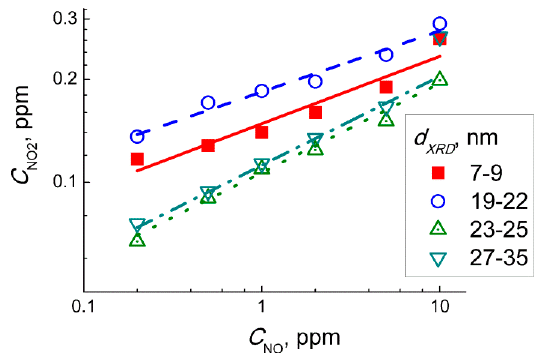
Figure 11. Concentration of NO 2 in the gas mixture NO + air estimated from the sensor signals of WO 3 with different grain size to the given concentrations of NO, under the assumption that the latter were controlled by incipient NO 2 formed by gas-phase oxidation of NO in air.